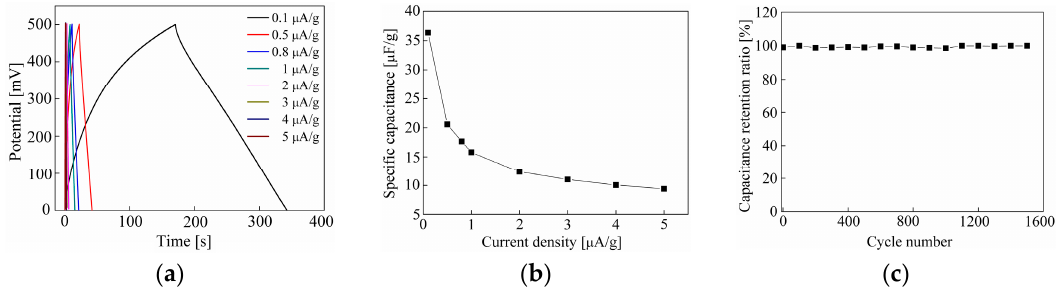
Figure 8. ( a ) Galvanostatic charge–discharge curves of the LATP composite with different current densities; ( b ) specific capacitances of LATP calculated from galvanostatic charge–discharge measurements; ( c ) change of capacitance during 1500 cycles of charge–discharge using a potential range of 0–0.5 V and a current density of 2 µA/g.